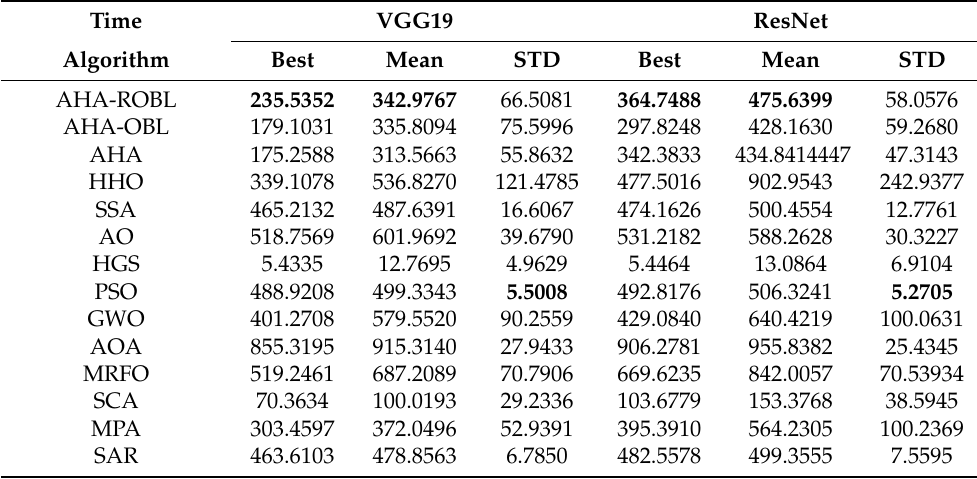
Table 10. Comparison of the performance of deep feature models of the AHA-ROBL with other recent optimizers versus avg.